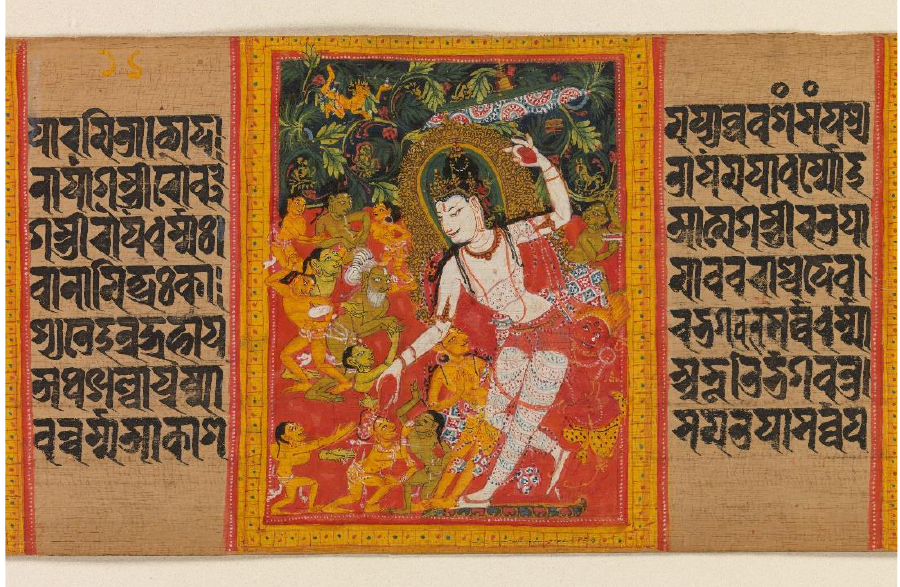
Figure 2. Avalokitesvara from an A ṣṭ asāhasrika Prajñāpāramitā . Period: Pala period. Date: early 12th century. Culture:Bengal, eastern India or Bangladesh. Dimensions: Page: 2 3/4 × 16 7/16 in. (7 × 41.8 cm). Image: 2 1/2 × 1 15/16 in. (6.4 × 4.9 cm). Credit Line: Purchase, Lila Acheson Wallace Gift, 2001. Accession Number: 2001.445l. Metropolitan Museum.